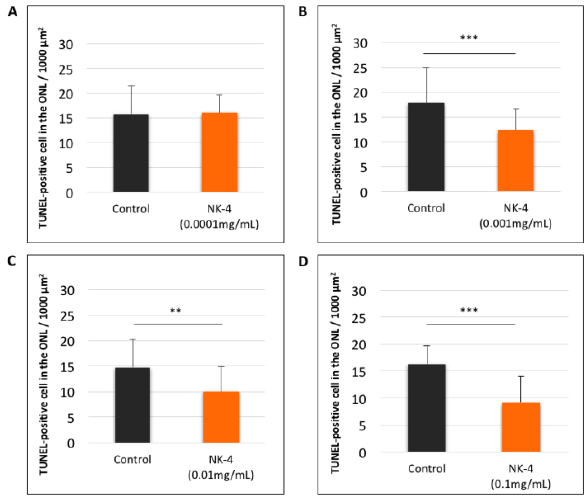
Figure 3. Quantitative analysis of TUNEL-positive cells (mean values of a, b, c, d, e, and f sites) in retinal sections. ( A ): NK-4 (0.0001 mg/mL)-injected retinas vs. control groups; ( B ): NK-4 (0.001 mg/mL)-injected retinas vs. control groups; ( C ): NK-4 (0.01 mg/mL)-injected retinas vs. control groups; ( D ): NK-4 (0.1 mg/mL)-injected retinas vs. control groups. The number of TUNEL-positive cells was significantly decreased in the ONL of the eyes injected with higher concentrations of NK-4, ranging from 0.001 to 0.1 mg/mL, compared with control vehicle-injected eyes ( p < 0.0001, p = 0.001, p < 0.0001, respectively, one-factor ANOVA, post hoc test). **: p < 0.01, ***: p < 0.001.